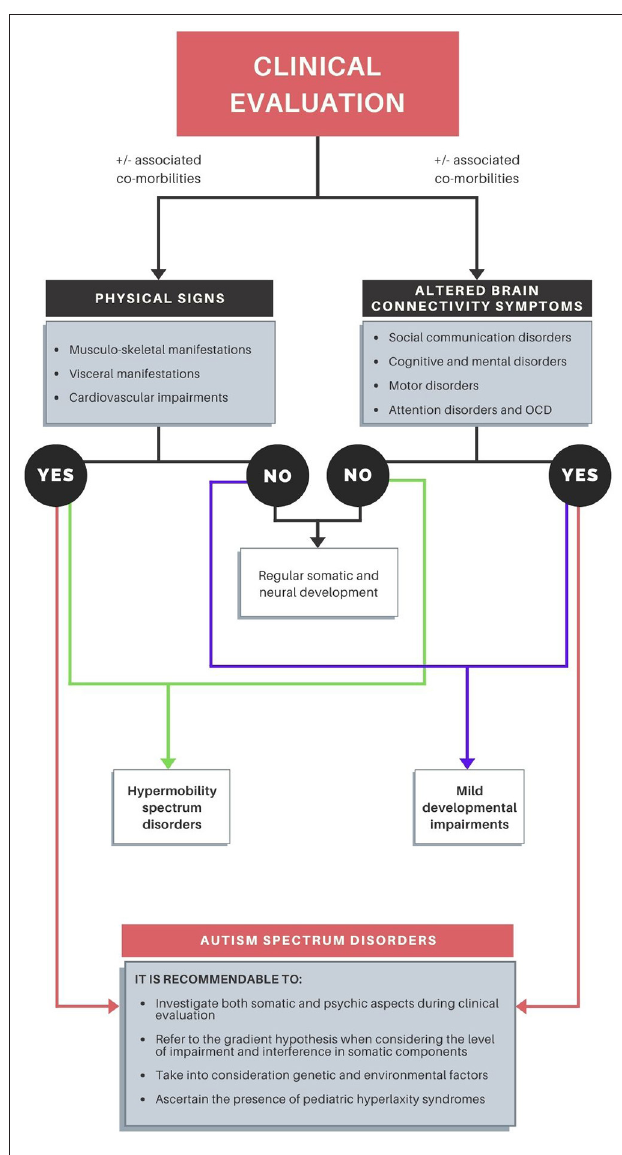
FIGURE 3 | Clinical evaluation model according to the “connectivome